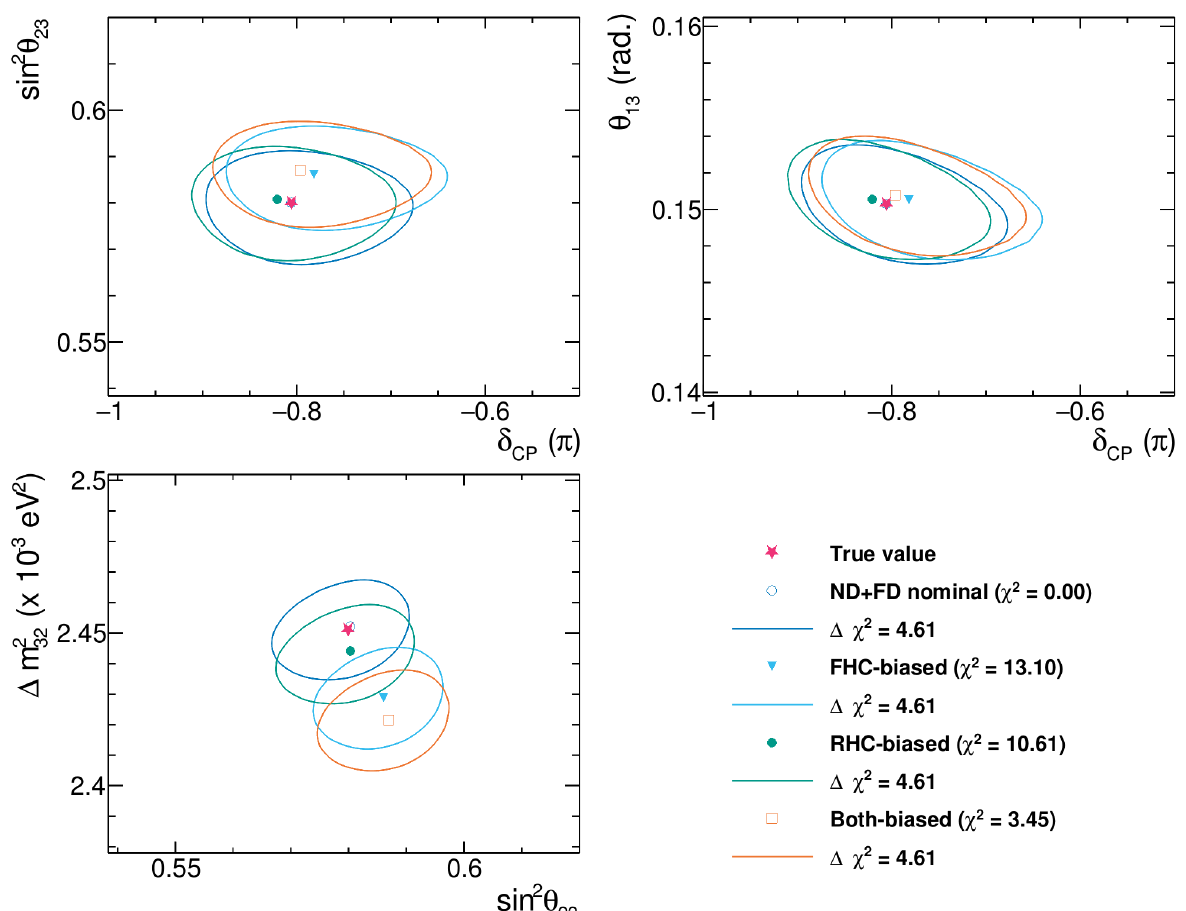
Figure 133. The oscillation parameter postfit 90% confidence contours with true and fake data best fit values. FHC, RHC and both flux changes were assumed and shown in different colors. The best fit χ 2 values are given in the